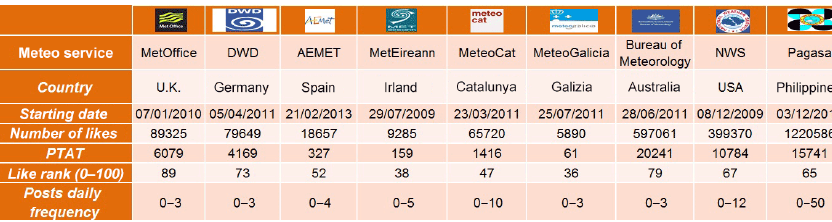
Figure 5. General Facebook information about selected NMSs (May